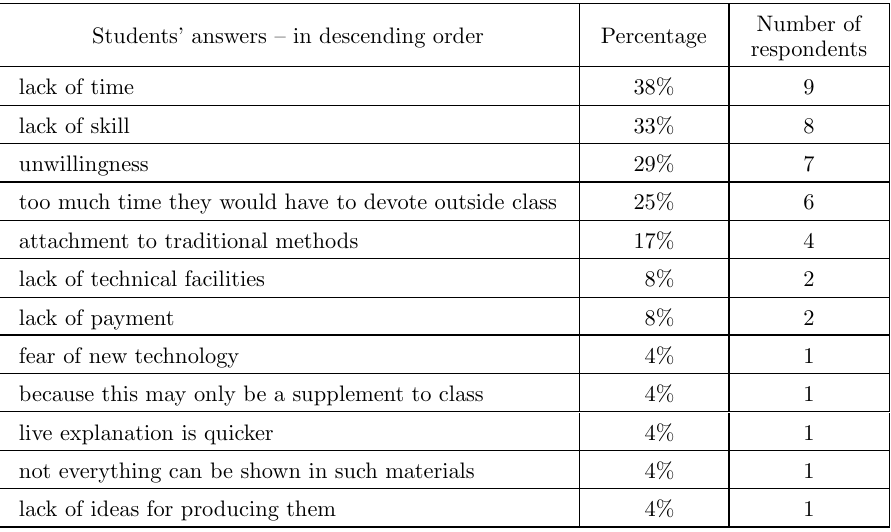
Table 4. Distribution of students’ answers to the open-ended question “Why do you think teachers rarely use videos/presentations/ interactive materials/animations in